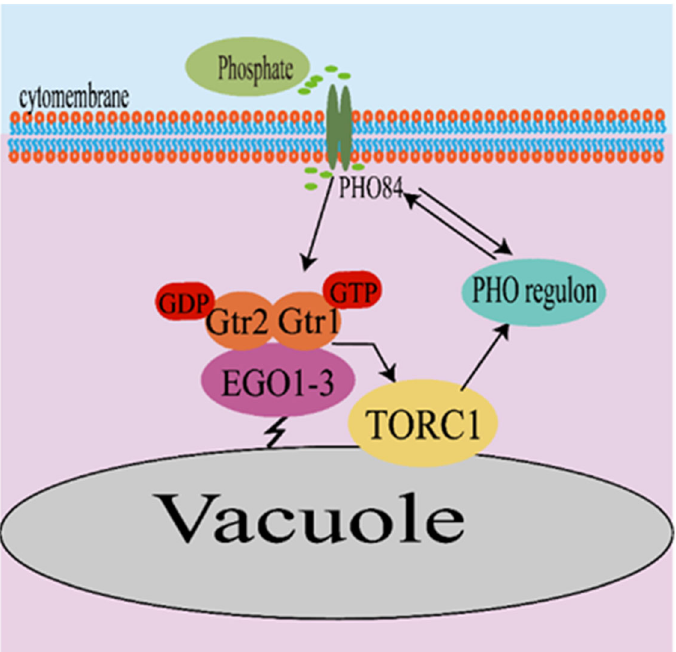
Figure 3. Phosphate regulates TORC1 activity in S. cerevisiae. In the S. cerevisiae model, Pho84 can sense the changes of intracellular phosphate concentrations to regulate Gtr1 ‐ mediated TORC1 activation; in turn, TORC1 also regulates the PHO regulon.